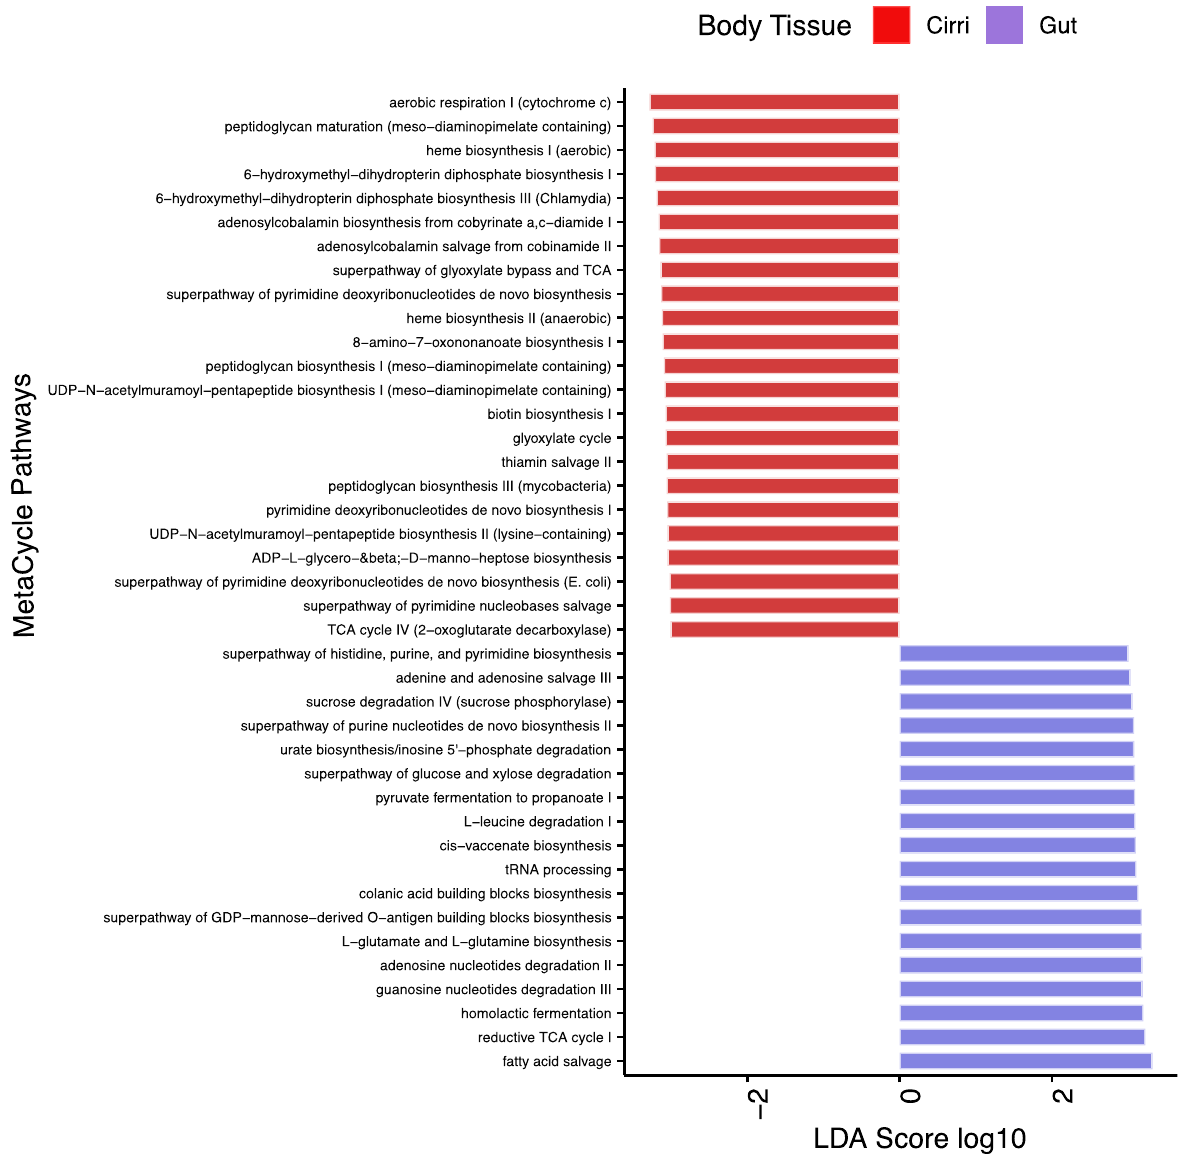
Fig. 5 Predictive MetaCyc pathways based on ASVs enriched in cirri and gut based on indicator species analysis. The top distinct functions between body types determined by linear discriminant analysis (LDA) effect size (LEfSe)